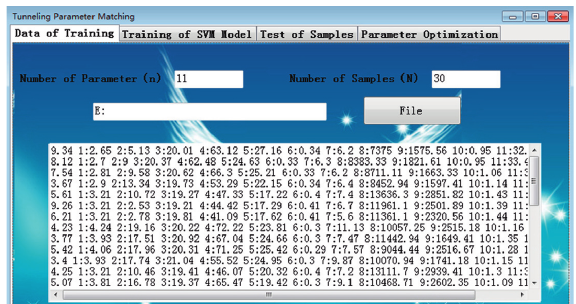
Figure 3: The reading interface of the training sample.